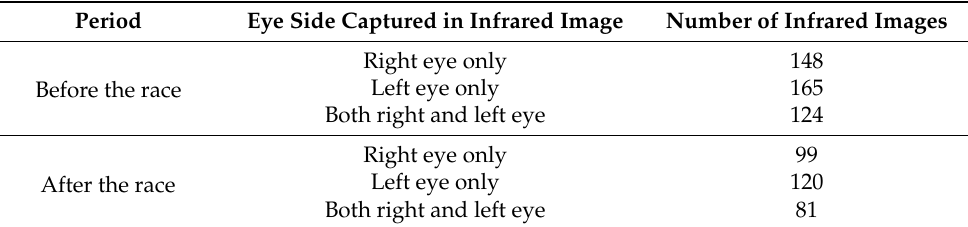
Table 1. The distribution of infrared images that captured the right eye, left eye or both eyes, before and after the race. Period Right eye only 148 Left eye only 165